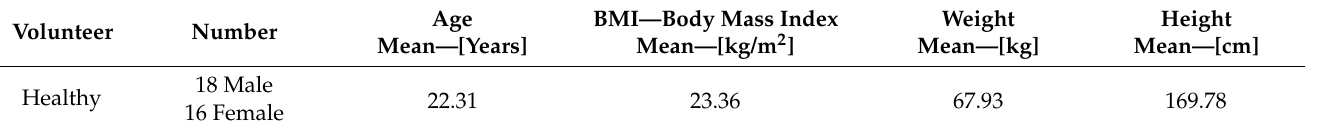
Table 1. Data of the healthy volunteers.